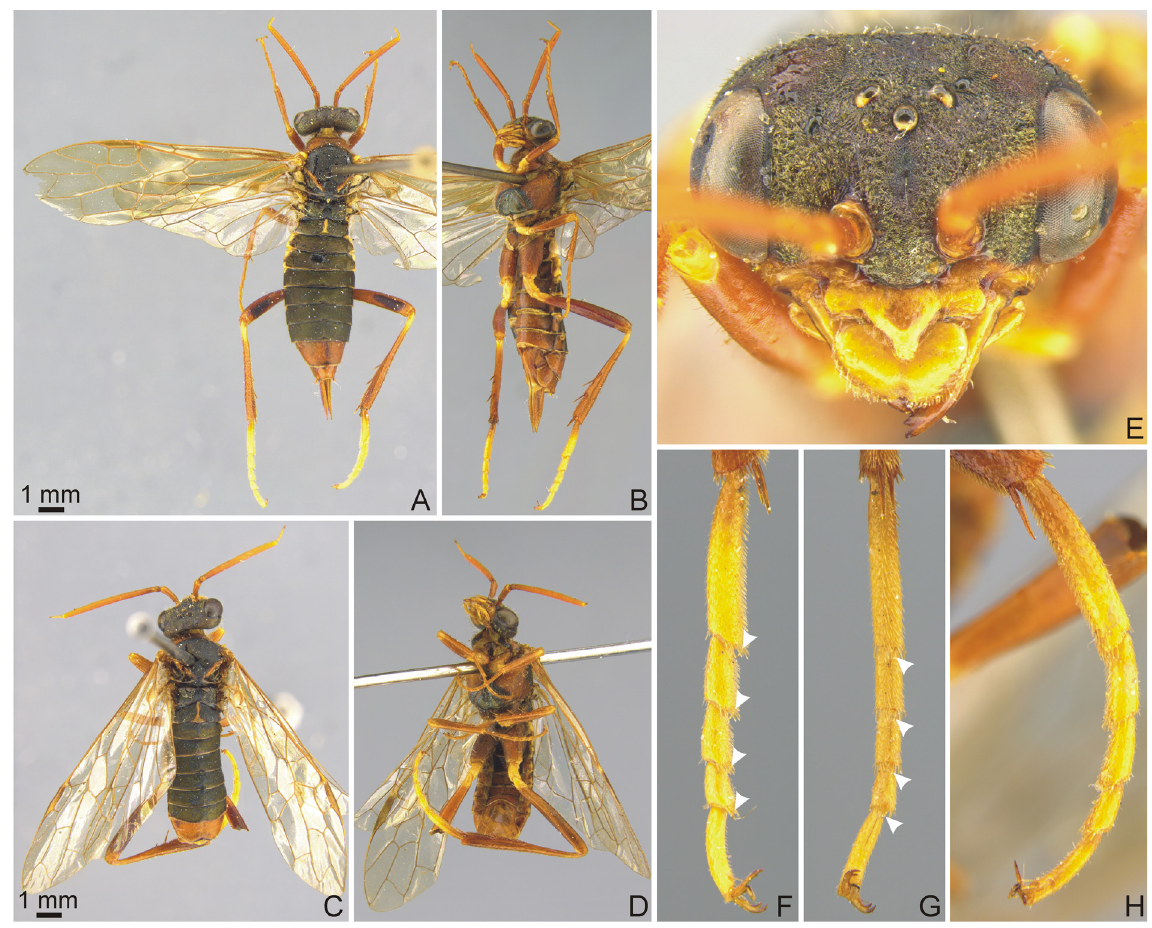
Fig. 8. Megaxyela parki Shinohara, 1992. A–B . Habitus dorsal/lateroventral (♀, DEI-GISHym 18509, NSMT). C–D . Habitus dorsal/lateroventral (♂, 710, NSMT). E . Head frontal (♂, 710, NSMT). F–G . Metatarsus lateral/ventral, arrowheads indicate pulvilli (♀, 18509, NSMT). H . Metatarsus lateral (♂, 710,